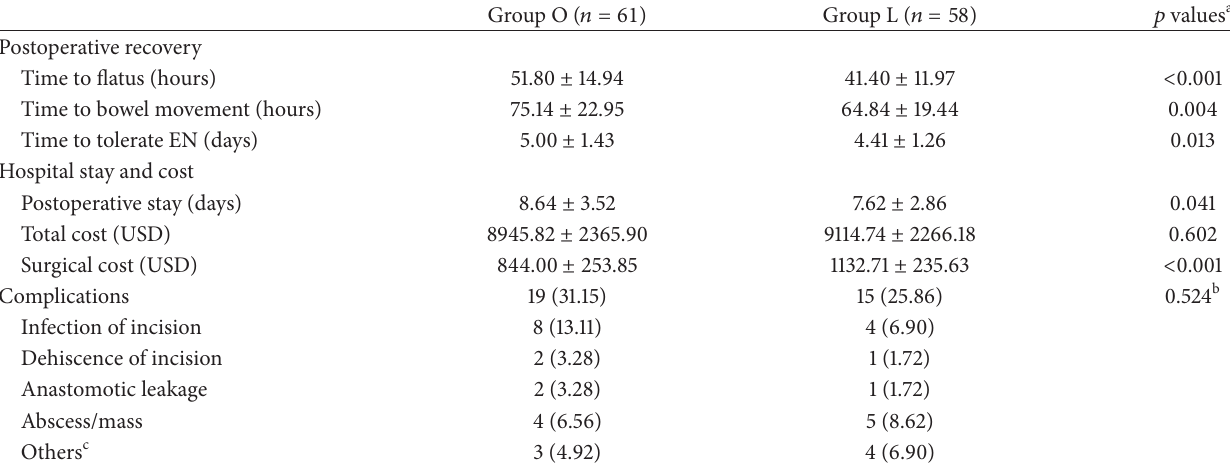
Table 3: Comparison of clinical outcomes between groups.